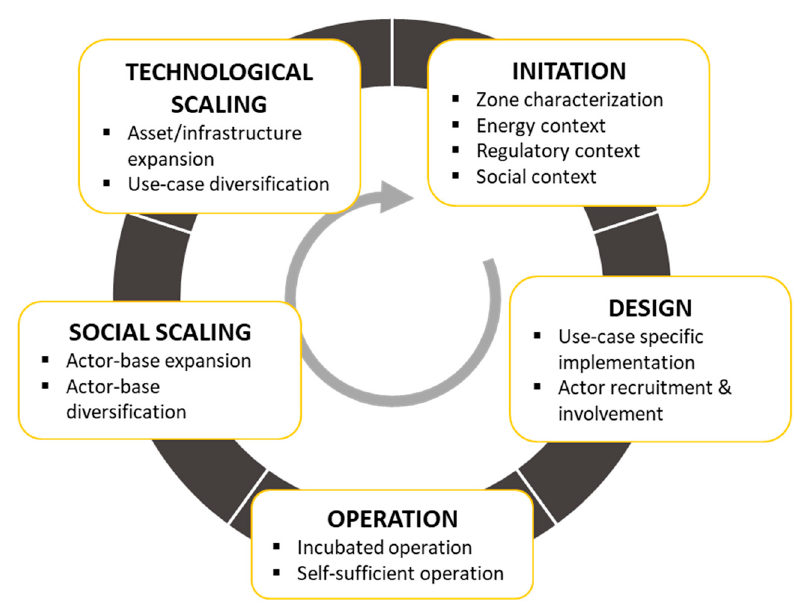
Figure 13. Overview of the generalized energy community project lifecycle.